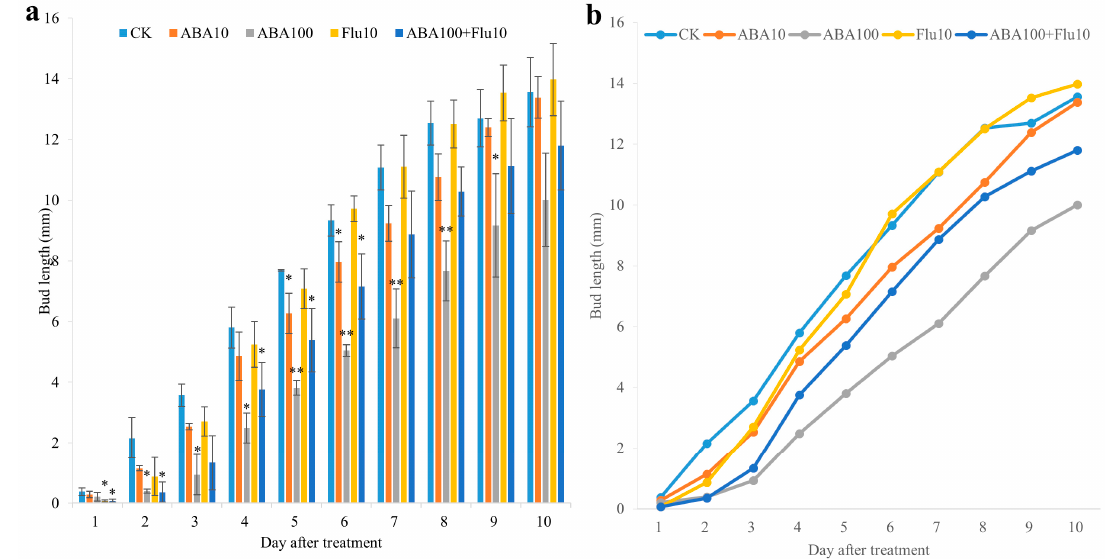
Figure 7. Exogenous ABA suppressed axillary bud outgrowth. Signal-bud node was inserted into the split-plate with MS media supplied with DMSO (control, CK), 1 µ m ABA, 10 µ m ABA, 100 µ m ABA, 10 µ m ABA biosynthesis inhibitor fluridon, and 100 µ m ABA + 10 µ m fluridon, separately. Bud length was measured from 1 day to 10 days by using camera and ImageJ software. ( a ) The bud length in different treatments and their difference comparison; ( b ) Bud length changing trend in different treatment in a visual sweep way. Data are mean ± SE of three biological replicates. Asterisks indicate significant differences between each treatment with CK for each time point at p < 0.05 (*) and p < 0.01 (**) level.